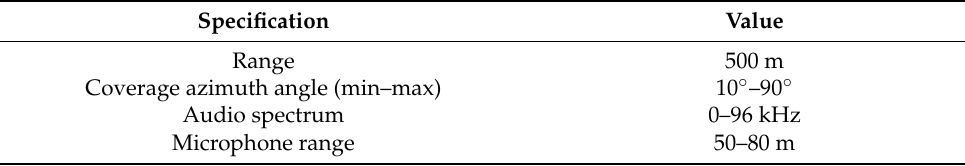
Table 8. Dedrone DroneTracker audio detector